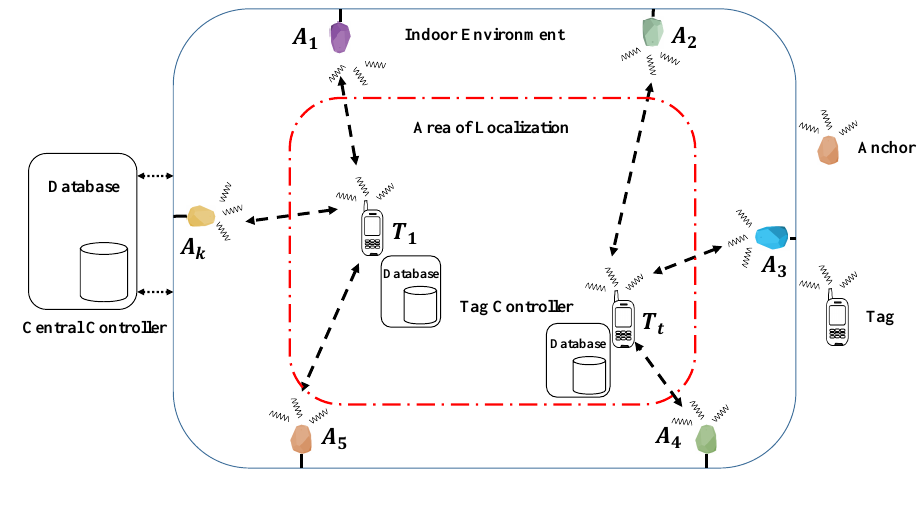
Figure 2. BLE based